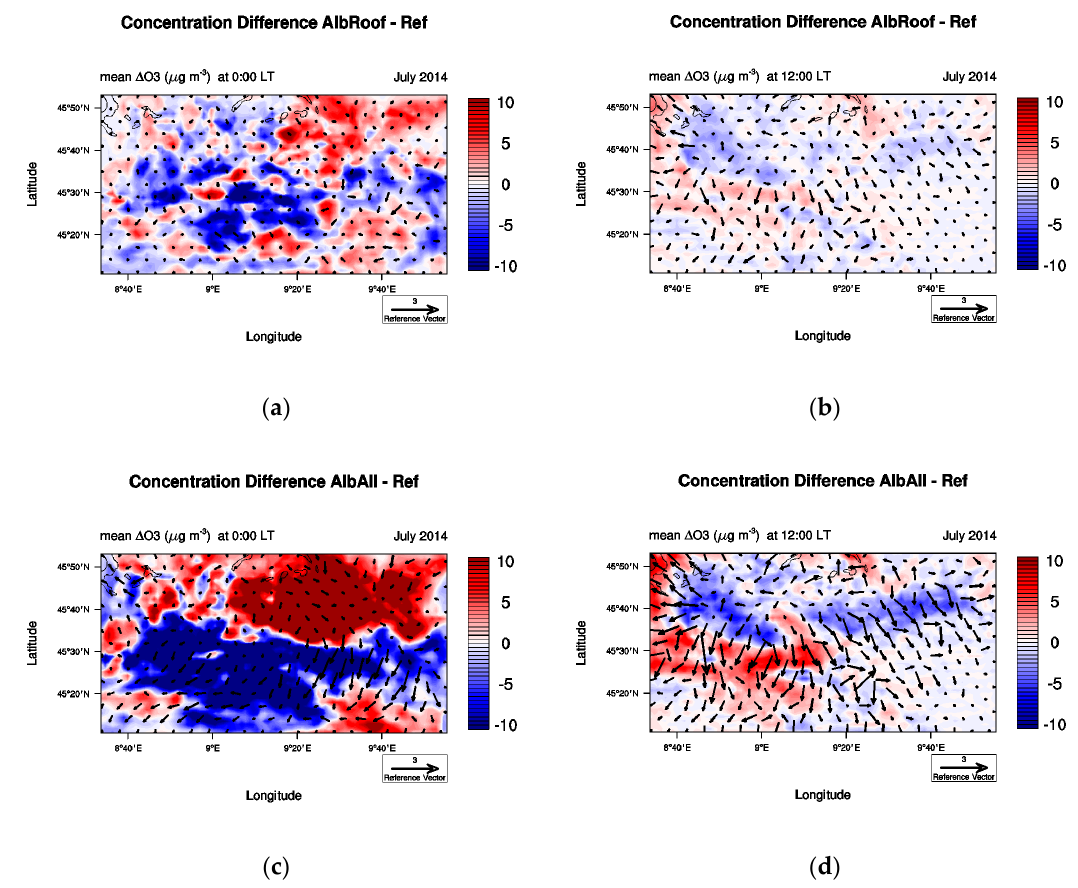
Figure 10. Same as Figure 8, but for ozone concentration: ( a , b ) difference between AlbRoof and Ref, ( c , d ) difference between AlbAll and Ref.